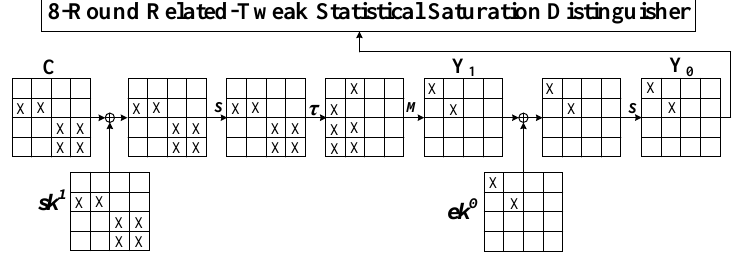
Figure 5: Key Recovery Attack on 10-Round QARMA -64 with No. 1